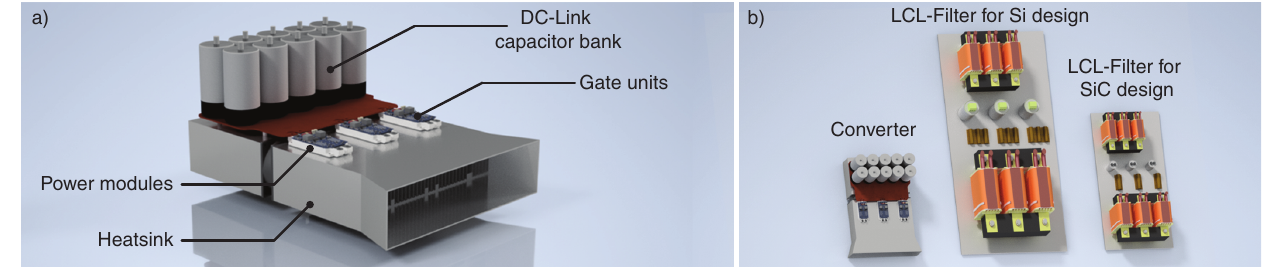
Figure 13. 3D renders of the proposed physical layout of the power converter including filter. ( a ) 3D model of the 2L- VSC, including power block, cooling solution and DC-Link. ( b ) Graphical 3D comparison of the LCL-Filter solutions with the power converter as reference (Optimized LCL-Filter physical layout should vary). Note that the designs were not